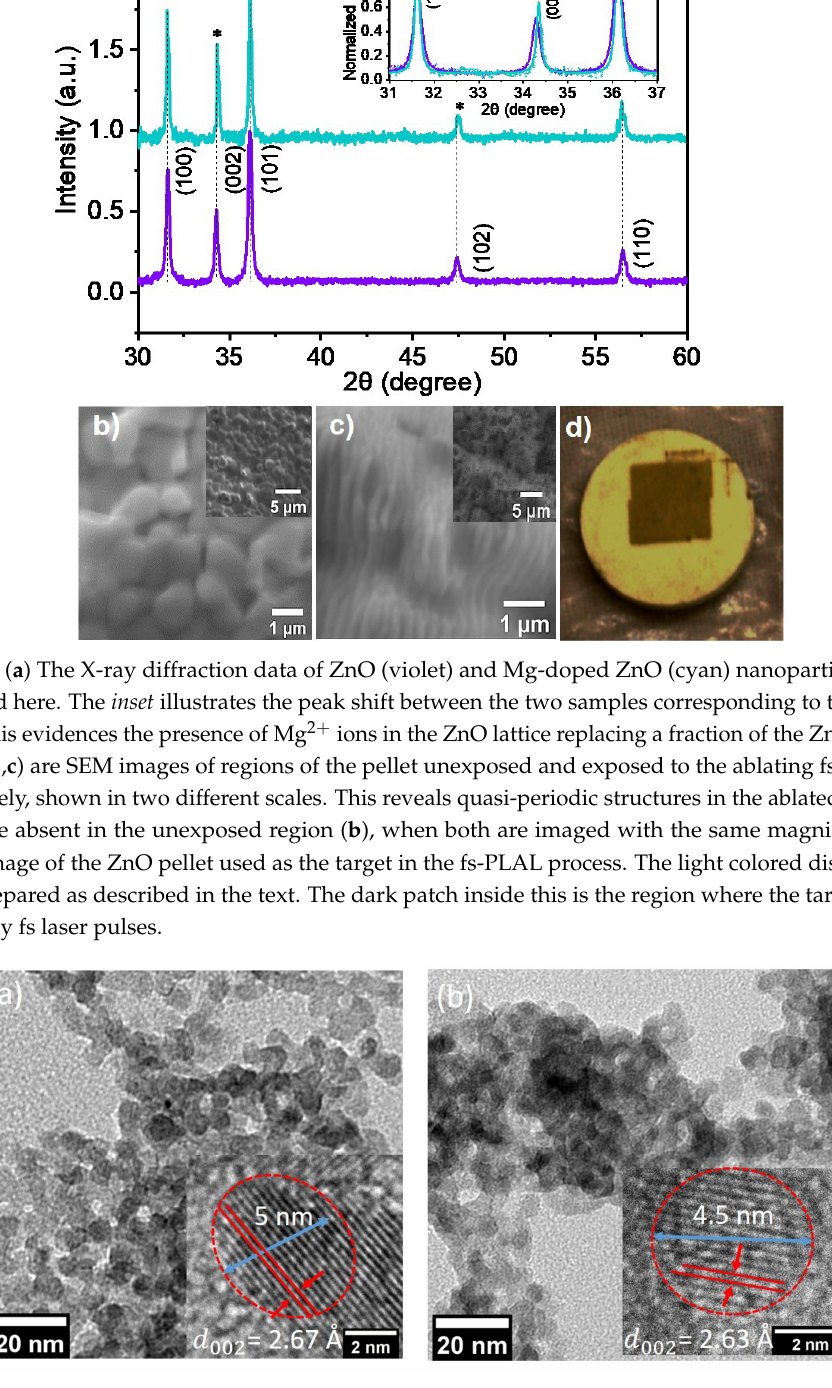
Figure 2. TEM images for ( a ) pristine ZnO and ( b ) Mg-doped ZnO. These nanoparticles were prepared using femtosecond laser pulses with an average power of 1.5 W. The inset in both panels shows the high-resolution TEM images from which the d -spacing was calculated to be 2.67 Å and 2.63 Å, respectively. These values are associated with (002) planes of the hexagonal wurtzite